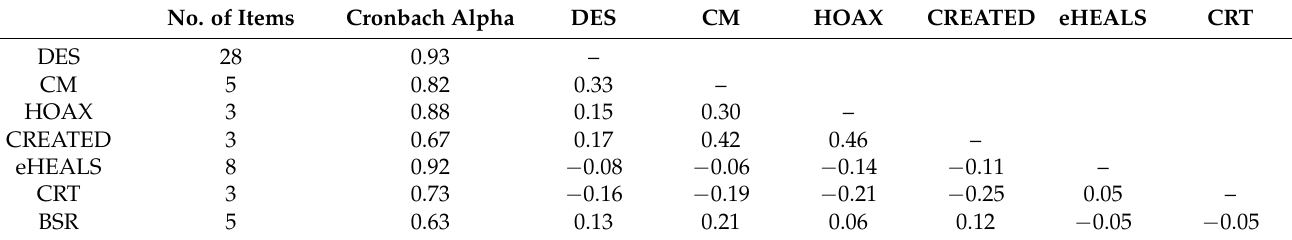
Table 2. Correlation matrix, Cronbach alpha and number of items in